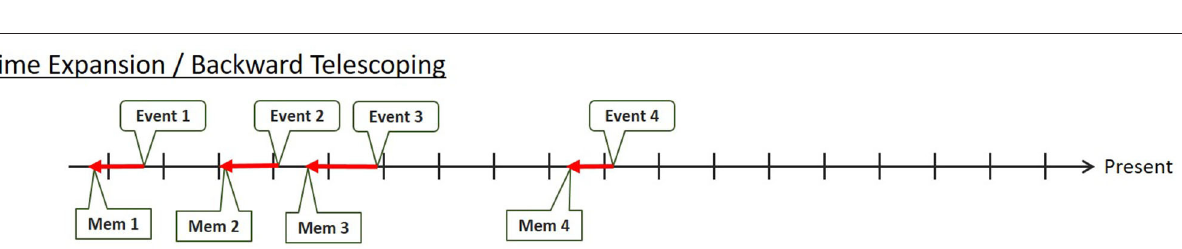
FIGURE 2 | Illustrative example of an internal clock model. Note that many versions with minor and major differences have been suggested, e.g., by Treisman (1963), Gibbon et al. (1984), Zakay and Block (1995), or Droit-Volet and Meck (2007). This depiction tries to capture the most common components without arguing in favor of or against any of the models suggested. For a detailed discussion regarding the development of internal-clock-models see Wearden (2016).